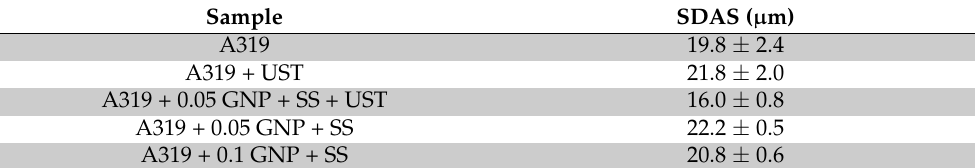
Table 3. Summary of average SDAS measurements for casting